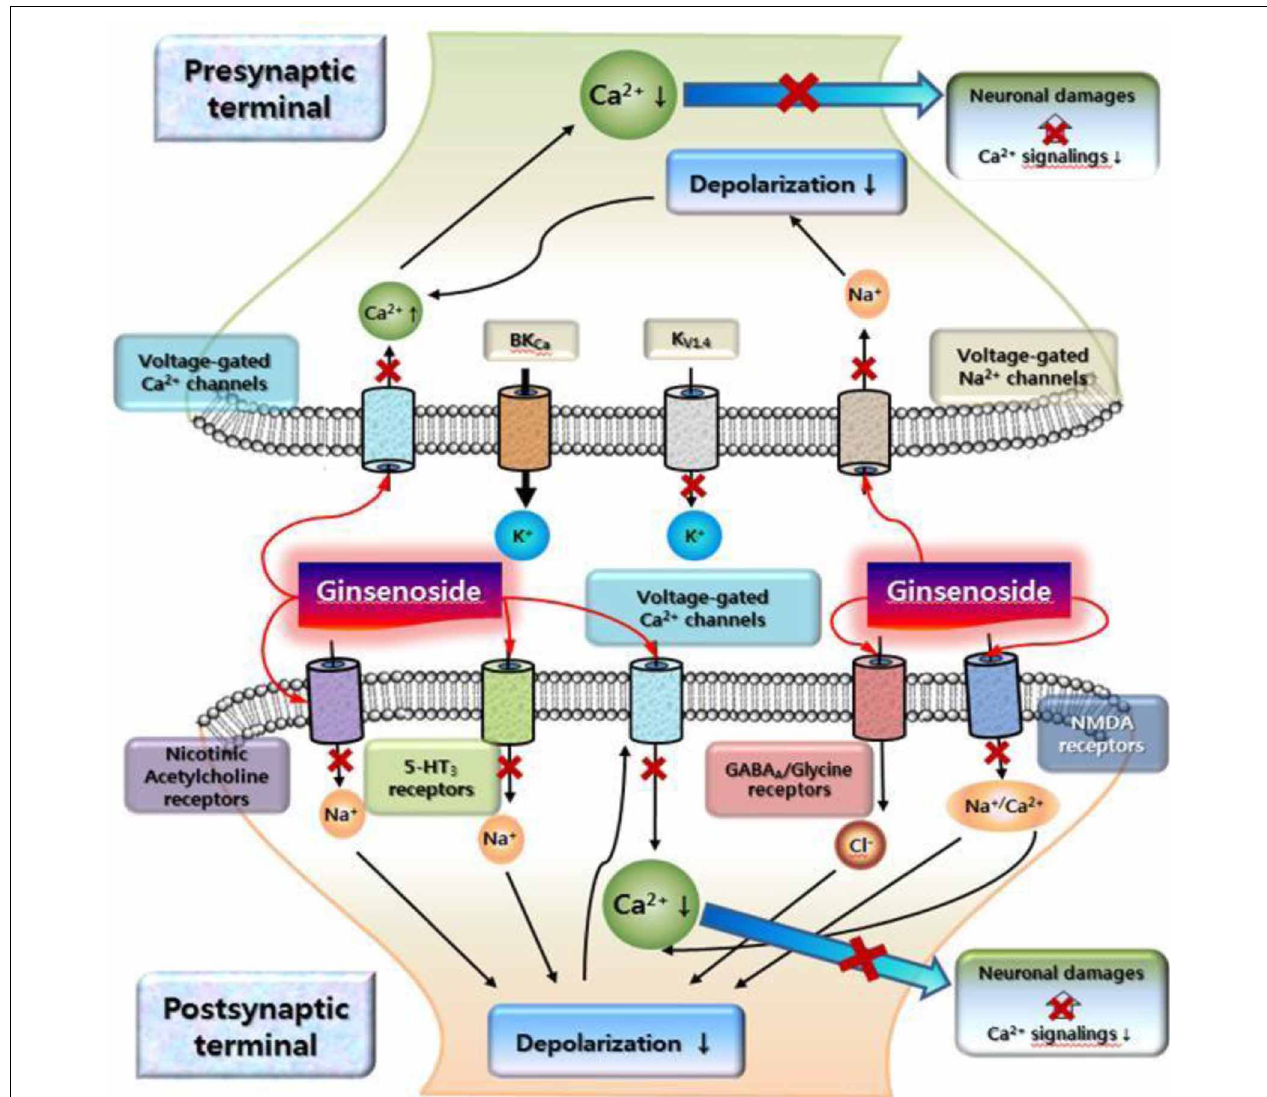
FIGURE 5 | A schematic illustration on cytosolic Ca 2 + overload signalings and ginsenoside-mediated attenuation against cytosolic Ca 2 + overload. This schematic drawing shows that cytosolic Ca 2 + levels could be elevated in ischemic or traumatic brain injury. The elevation of cytosolic Ca 2 + levels occurs either via direct activation of voltage-gated Ca 2 + channels or via depolarization caused by voltage-dependent Na + channel activation and other excitatory ligand-gated ion channels at pre- and post-synaptic sites. The overload of cytosolic Ca 2 + levels caused by excitatory neurotransmitters or neurotoxins may initiate the persistent activation of Ca 2 + -dependent